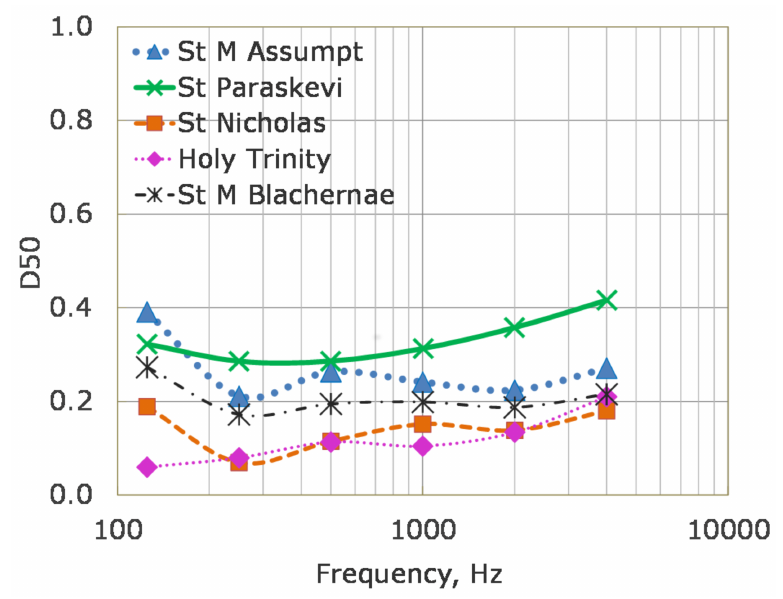
Figure 17. Measured results of definition (D 50